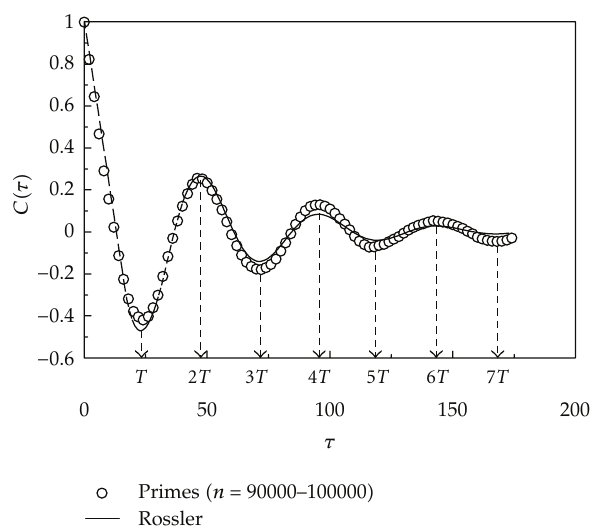
Figure 1: Autocorrelation of the v (cid:2) n (cid:3) functions for the ln-sequence (cid:2) circles (cid:3) in the interval 9 × 10 4 < n < 10 5 . The solid line correspond to autocorrelation function computed for the telegraph signal generated by the R¨ossler attractor fluctuations overcoming the threshold x (cid:7) 7. In order to make the autocorrelation functions comparable a rescaling has been made for the R¨ossler autocorrelation function.